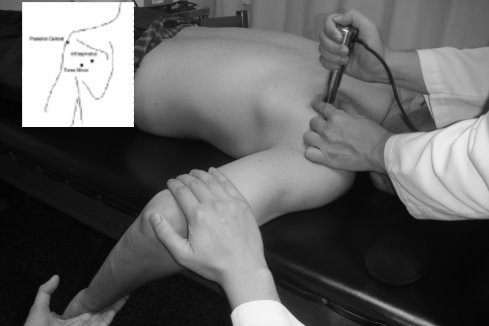
The stiffness measurement sites for the 3 muscles using myotonometer probe placement over the 3 posterior shoulder muscles. Posterior deltoid: two fingerbreadths caudad to posterior margin of the acromion; infraspinatus: two fingerbreadths below medial portion of spine of scapula; and teres minor: one-third of the way between acromion and inferior angle of scapula along lateral border.